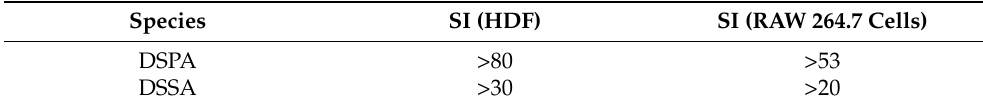
Table 2. Selectivity index (SI = IC50 RAW 264.7 cells.